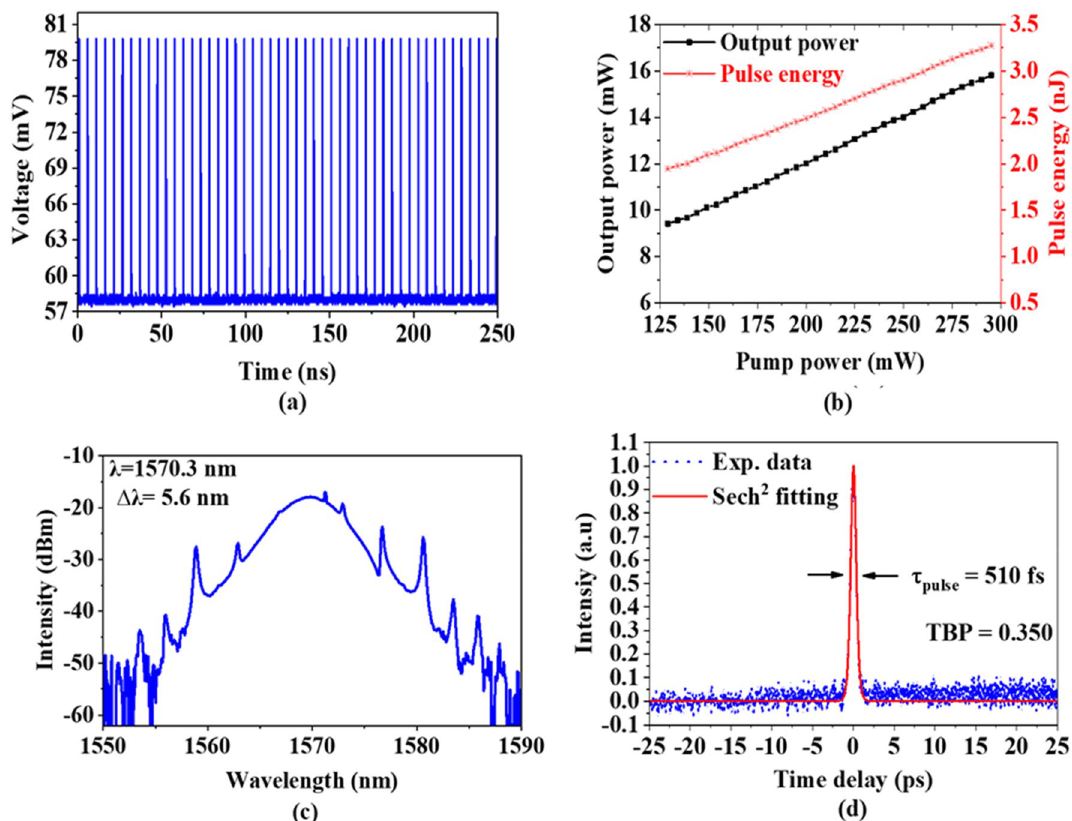
Figure 6. Temporal and spectral characteristics of the soliton pulse with 35 m cavity length ( a ) typical pulse train, ( b ) Pulse energy and output power changing with pump power ( c ) output spectrum, and ( d ) autocorrelator trace.